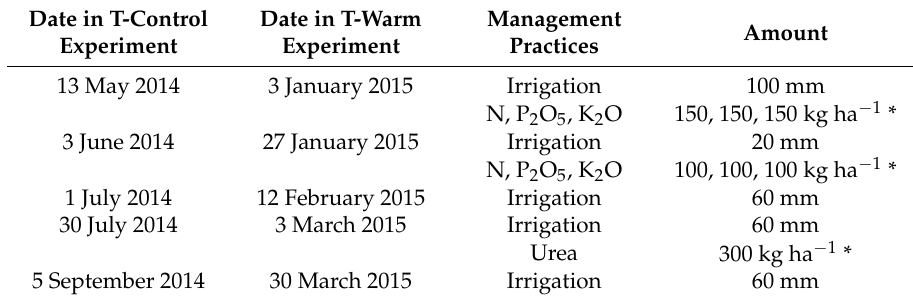
Table 1. Irrigation and fertilization applications for maize in the T-control and T-warm experiments.